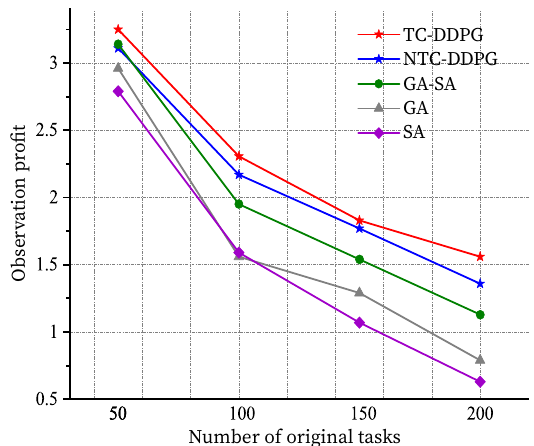
Figure 11. Observation time period selection results.